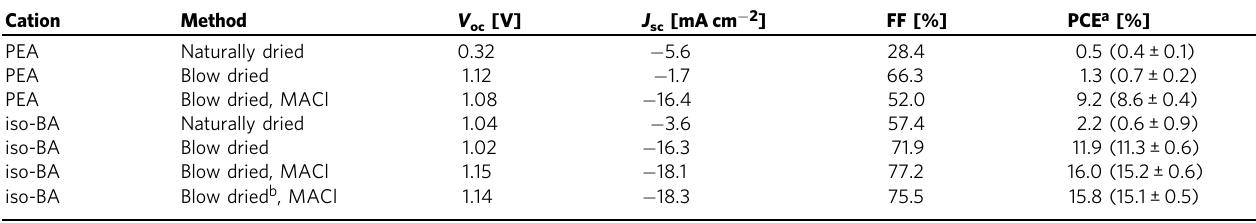
Table 1 Performance of solar cells using different cations and drying methods.